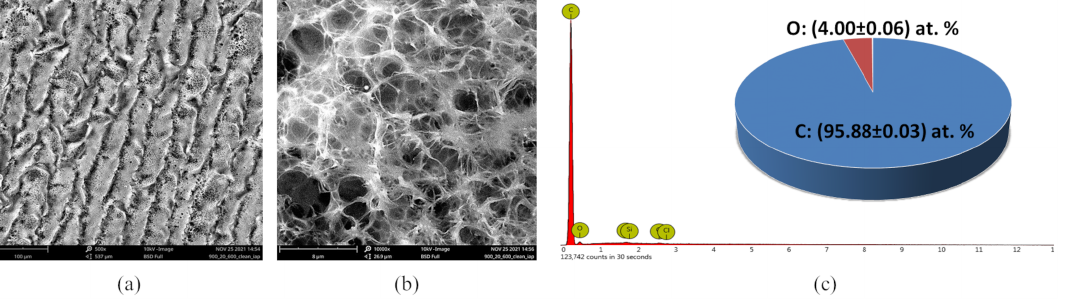
Figure 2. SEM and EDX characterization of LIG on PI. ( a ) SEM at a magnification of ×500, where lines along which the laser passed can be observed. ( b ) SEM at a magnification of ×10,000, where a highly developed porous network is seen. ( c ) EDS spectra and the C and O content in LIG. Trace elements such as Si and Cl were left out of the pie chart, because those are elements found in the substrate and not in the graphene sample itself.